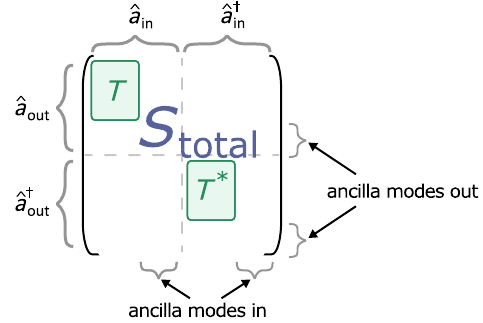
FIG. 2. The structure of the matrix S . The matrix elements total represent the coupling between the respective input modes (columns) and output modes (rows). Viewed as a 2 × 2 block matrix, nonzero elements in the off-diagonal blocks are respon- sible for active elements in the implementation. The trans- formation of interest, T , is contained in the upper-left